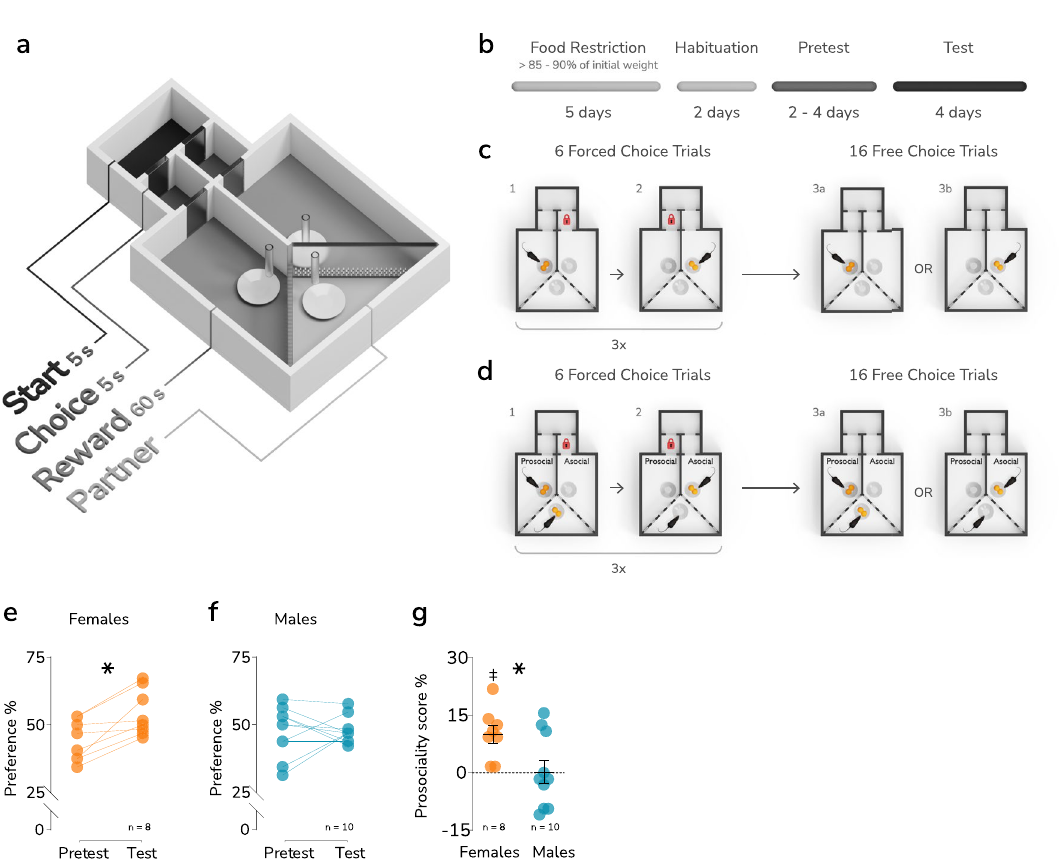
Figure 1. Prosocial choices in male and female mice. ( a ) A schematic representation of the testing apparatus. ( b ) Experimental schedule. ( C–D ) A diagram summarizing the pretest and test phases of the experiment, respectively. ( e–f ) The change in preference for the ‘prosocial’ compartment between the pretest and test phases in female and male mice, respectively. The results shown are the mean values from all sessions in the pretest and test phases. A significant difference between the phases is marked with a “*” (paired t-test p < 0.05). Respective group sizes are indicated below the graphs. ( g ) The difference between females and males prosociality score, calculated as test preference for the prosocial compartment minus pretest preference for the same compartment (%). The bar and whiskers represent the mean and s.e.m. values. A significant difference between means is marked with a “*” (t-test p < 0.05), and a significant difference vs. 0 is indicated by a “‡” (one-sample t test p < 0.05). The group sizes are indicated below the